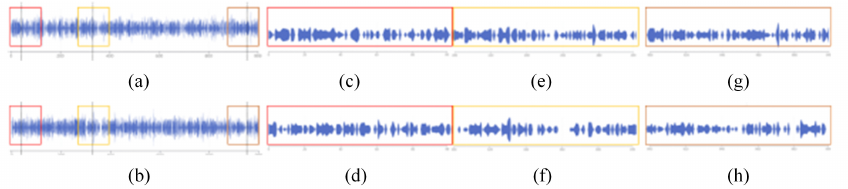
Figure 17. Features of pocket 4 and pocket 1 enlarged. ( a ) 1000 time steps(pocket 4). ( b ) 1000 time